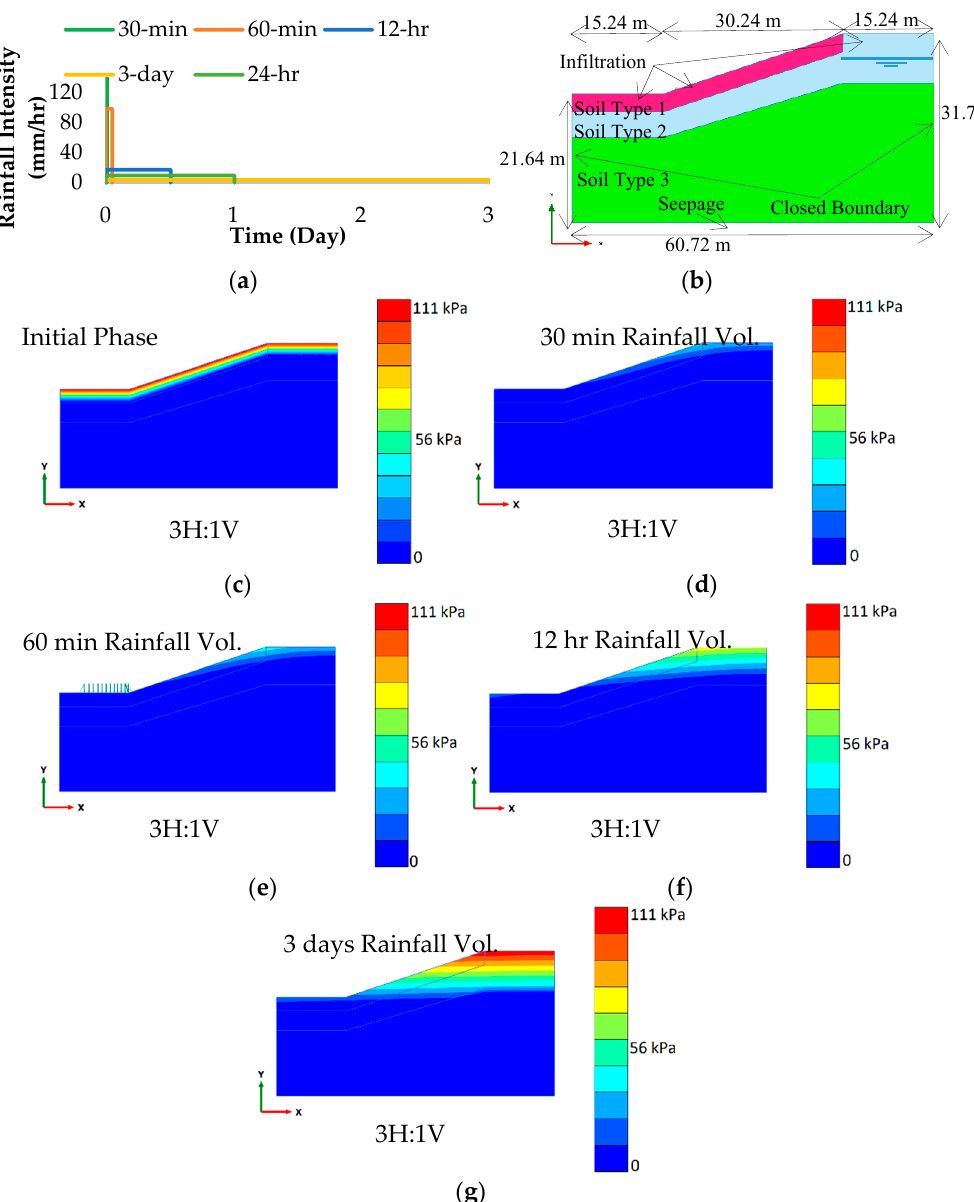
Figure 9. Suction profile variation of 3H:1V slope made of Yazoo clay: ( a ) Flow functions to simulate rainfall in FEM analysis, ( b ) the boundary condition for the soil model, ( c ) suction profile before rainfall, ( d ) suction profile after rainfall-30 min, ( e ) suction profile after rainfall-60 min, ( f ) suction profile after rainfall-12 h ( g ) and suction profile after rainfall-3 days.